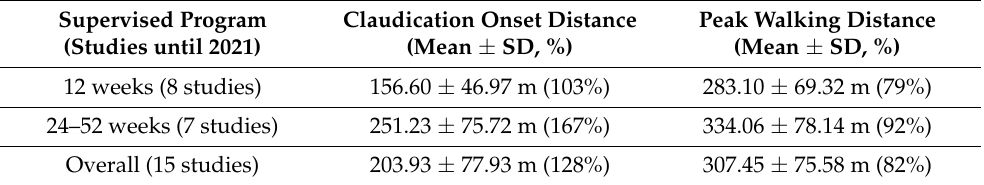
Table 3. Change in Walking Distance after cardiac rehabilitation programs in patients with PAD. For PAD patients enrolled in different cardiac rehabilitation programs, there is a direct proportionality between duration and claudication onset distance or change in peak walking